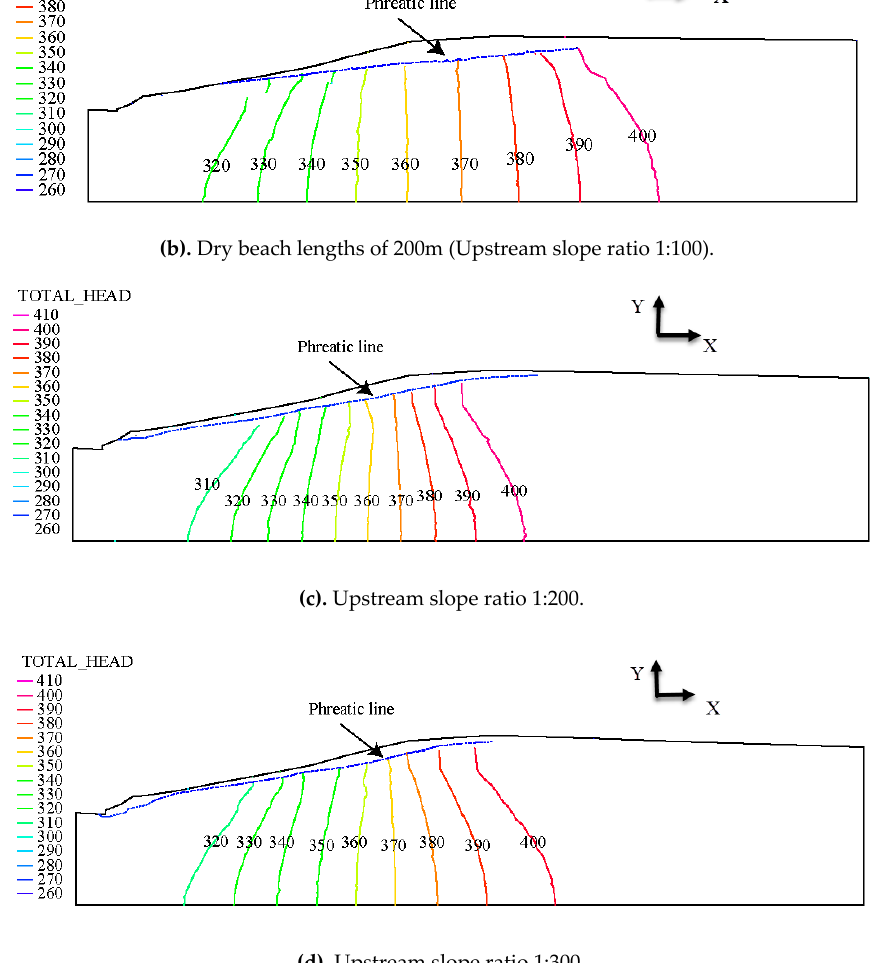
Figure 8. Seepage calculation with drybeach lengths and Seepage calculation with upstream slope ratio. ( a ) Dry beach lengths of 100 m; ( b ) Dry beach lengths of 200 m (Upstream slope ratio 1:100); ( c ) Upstream slope ratio 1:200; ( d ) Upstream slope ratio 1:300.